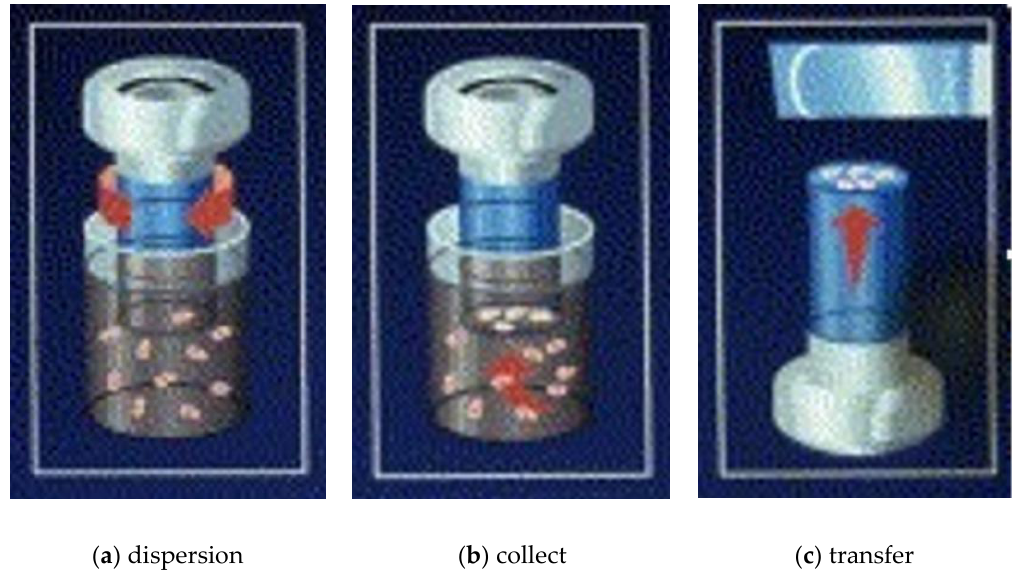
Figure 1. Schematic diagram of multi-spectral imaging system based on multi-channel narrow-band